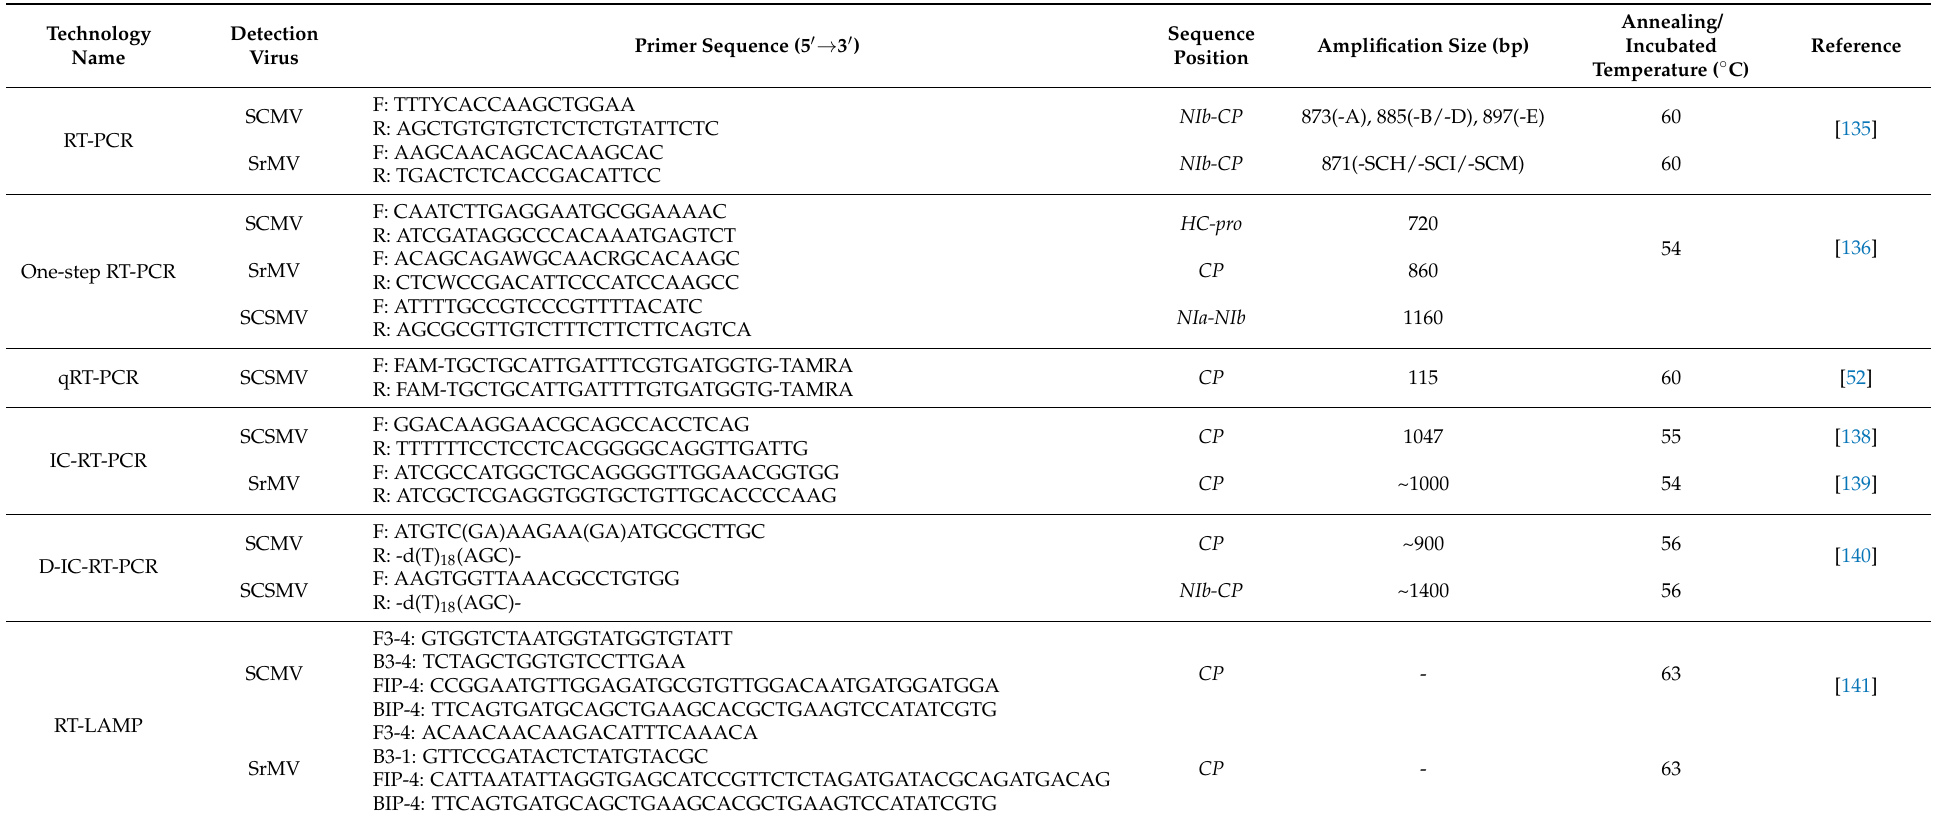
Table 3. The primer sequence information of different molecular detection techniques for sugarcane mosaic